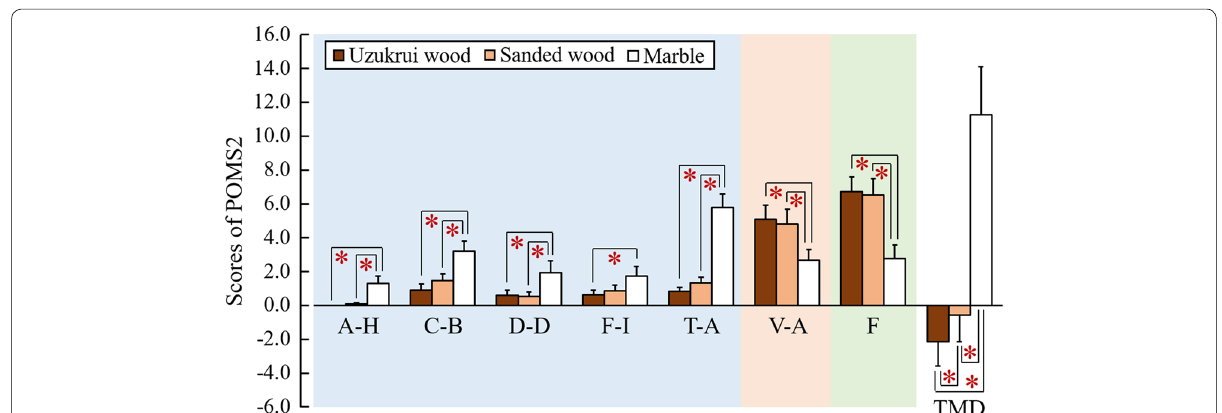
Fig. 8 Subjective feelings using the Profile of Mood States Second Edition after sole of the feet contact with the materials. n * p < 0.05 as determined by using the Wilcoxon signed-rank test with Holm correction. A-H anger–hostility, C-B confusion–bewilderment, D-D depression–dejection, F-I fatigue–inertia, T-A tension–anxiety, V-A vigor–activity, F friendless, TMD total mood